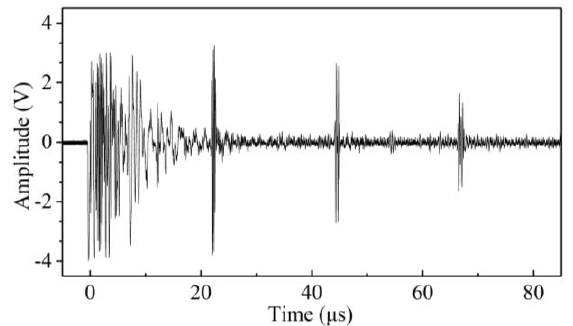
Figure 6. The typical time-domain signals of the received shear waves (sample C3, σ = 200 MPa).